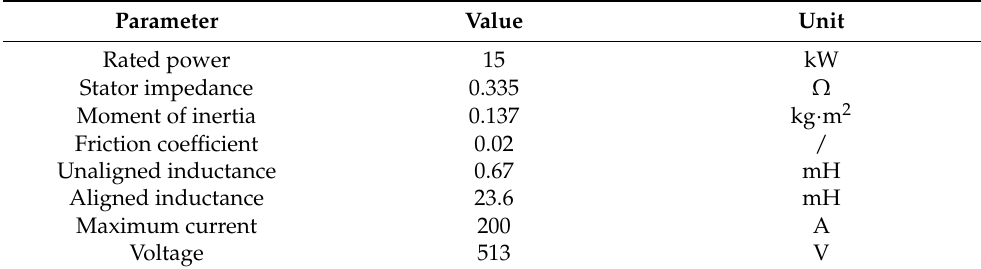
Figure 7. Simulation model of the SRD system. Table 1. Parameters of the SRM.